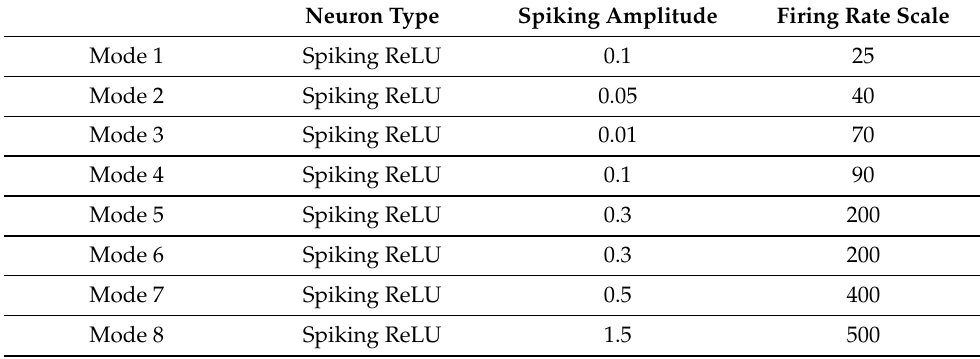
Table 1. Main spiking network parameters.